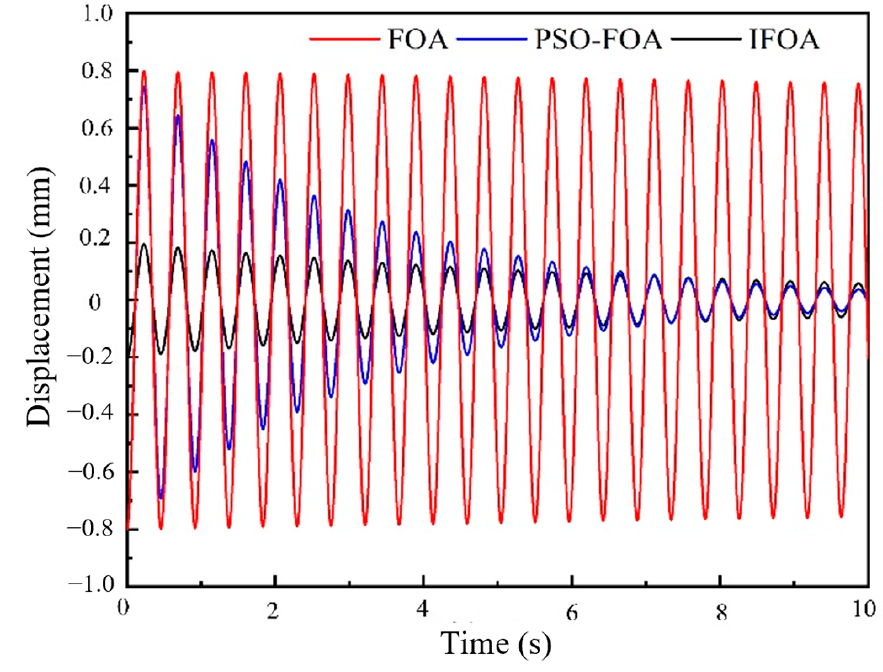
Figure 13. Vibration displacement of vehicle body (n = 890 r/min).